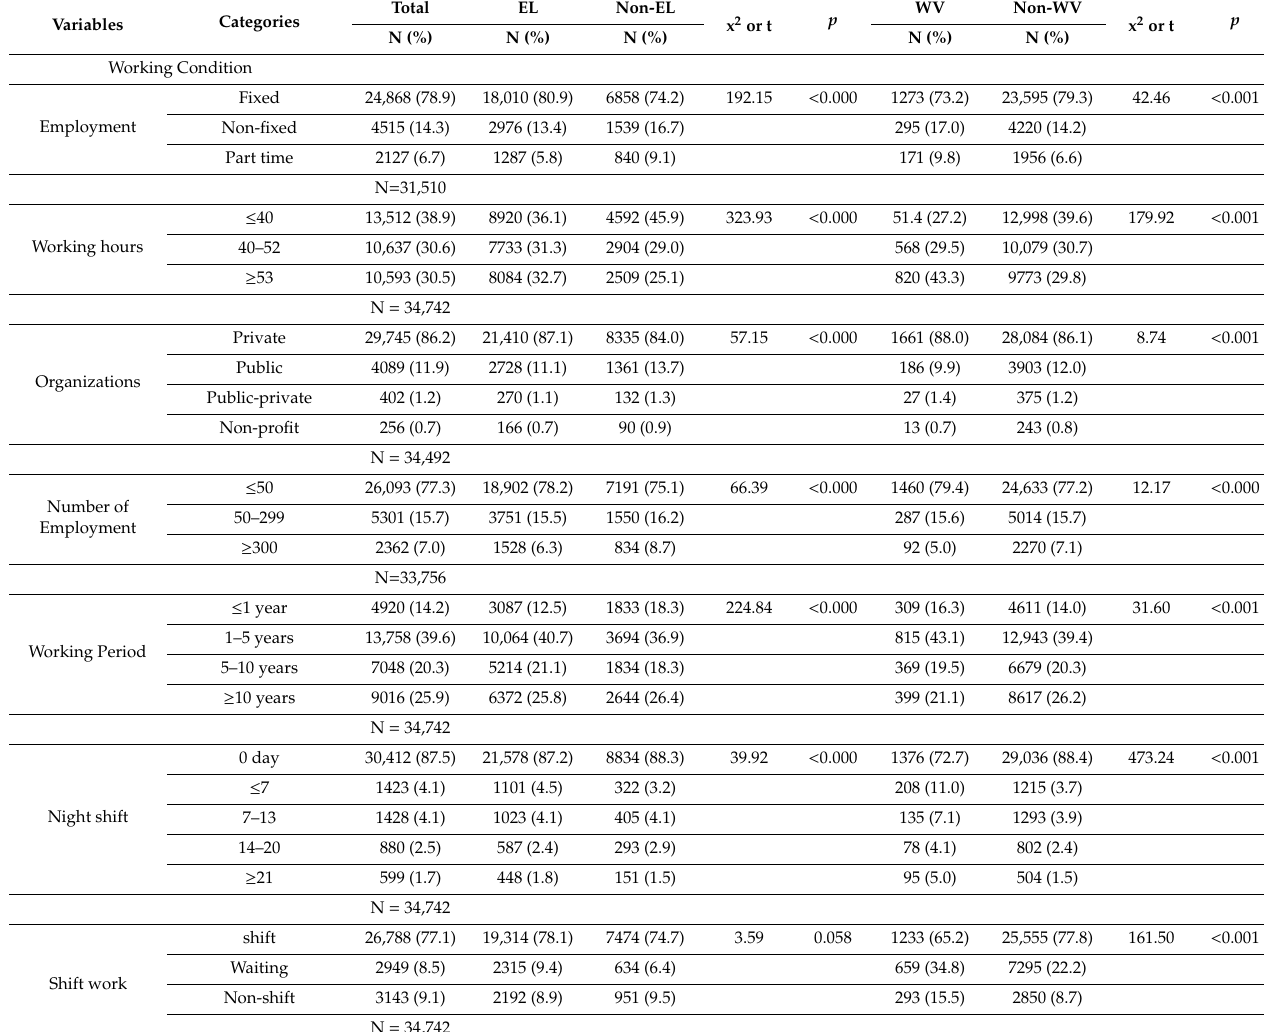
Table 2. Comparison of working conditions